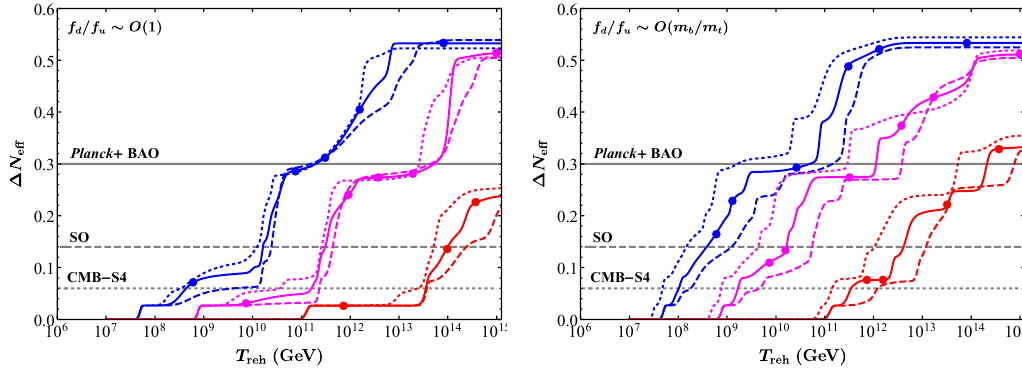
Figure 3 . Left panel: the “ flavor stairway ” plot or the predicted ∆ N eff for the model as a function of the reheating temperature T reh , assuming that f u = 8 × 10 13 GeV (blue), 10 15 GeV (magenta), and 10 17 GeV (red), and f d = f u (solid), f d = 3 f u (dashed), and f d = 0 . 3 f u (dotted). The Yukawa couplings for the T and B quarks are both taken to be unity. On the solid lines, the dots indicate the points at which T reh is equal to a heavy vector-like quark mass. Note that when f d = f u , the masses of the two heaviest vector-like quarks are degenerate, so we may only expect a maximum of 5 dots to appear on each solid line. The gray solid line indicates the 95% -CL upper limit of ∆ N eff from Planck and BAO [50], while projected 95% -CL limits are depicted from the Simons Observatory [51] (dashed) and CMB-S4 [48] (dotted). Right panel: the same as the left one, but with f d = ( m b /m t ) f u (solid), f d = 3( m b /m t ) f u (dashed), and f d = ( m b /m t ) f u